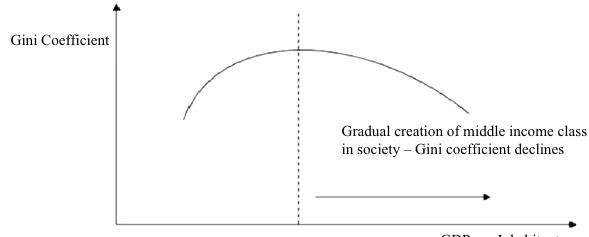
Figure 3: Dependence of Gini coe ffi cient on GDP.